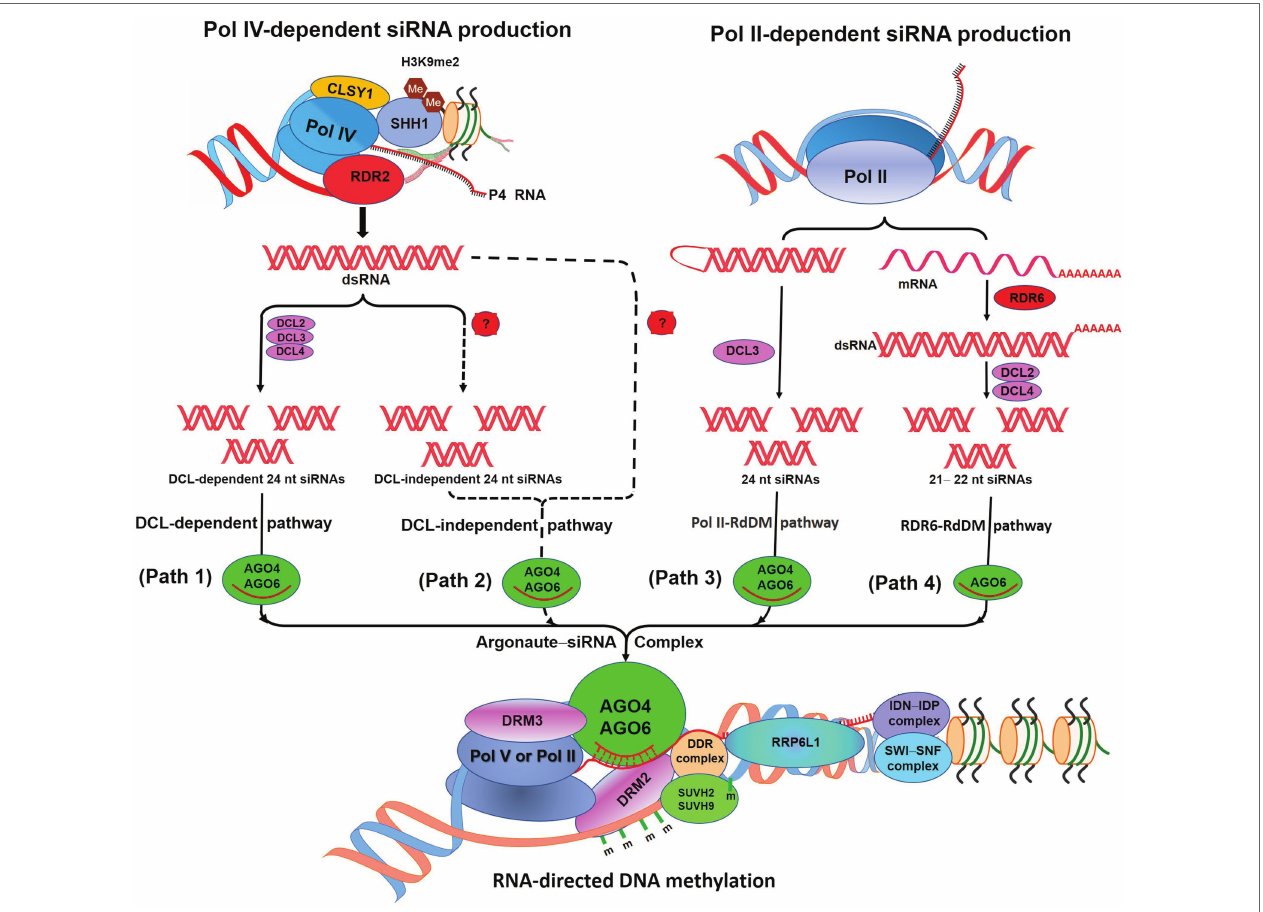
FIGURE 1 | Diagrammatic representation of the RNA-directed DNA methylation (RdDM) pathway. According to the canonical RdDM pathway, noncoding P4 RNAs are produced by RNA polymerase IV (Pol IV). SHH1 binds to dimethylated histone H3K9me2 and helps to recruit Pol IV at RdDM locus. (Path 1): P4 RNAs get converted into double-stranded RNAs (dsRNAs) by RDR2, which get cleaved into 24 nucleotide (nt) siRNAs by DICER-like protein 2 (DCL2),ss DCL3, and DCL4. These siRNAs bound with Argonaute 4 or AGO6 participate in the RdDM. (Path 2): Methylation of RdDM loci in dcl1 - dcl2 - dcl3 - dcl4 mutant suggests the existence of DCL-independent RdDM. (Path 3): POL II produces 24 nt siRNAs with the help of DCL3 and scaffold RNAs at some of the RdDM loci. (Path 4): For some active transposons, mRNAs get converted into dsRNAs and get cleaved into 21 nt siRNAs by DCL2, DCL4 through RDR6–RdDM pathway. Involved in de novo